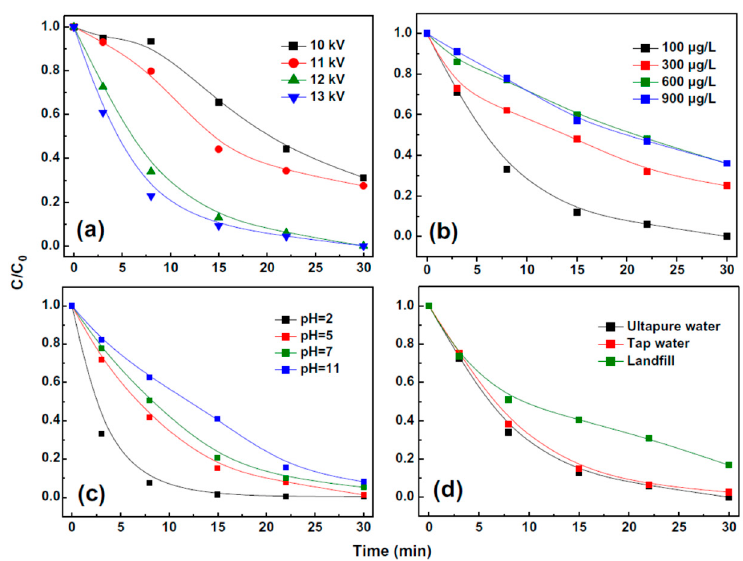
Figure 4. Effect of different parameters on E2 removal efficiency after treatment time of 30 min, showing the interferences with the process due to the complex nature of a landfill leachate solution ( a ) effect of peak voltage at E2 0 = 100 µg/L and pH 5.6; ( b ) effect of initial concentration (Vmax =12 kV, pH 5.6); ( c ) effect of pH value (Vmax = 12 kV, E20 = 100 µg/L); (d) effect of different solution matrices (Vmax = 12 kV, E20 = 100 µg/L, pH 5.6) [29].